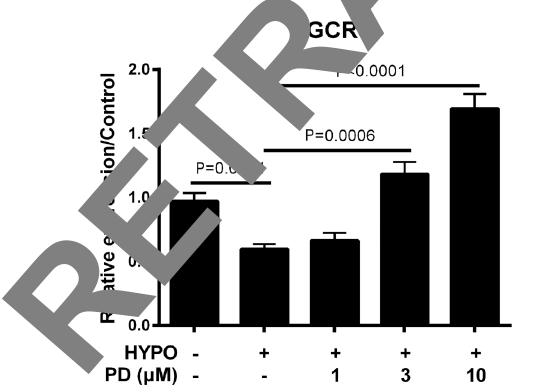
Figure 3. Polydatin (PD) increased the expression of DiGerorge syndrome critical region gene 5 (DGCR5) in hypoxia-induced (HYPO) injury of H9c2 cells measured by western blot. Data are reported as mean ± SD (ANOVA or Student ’ s t